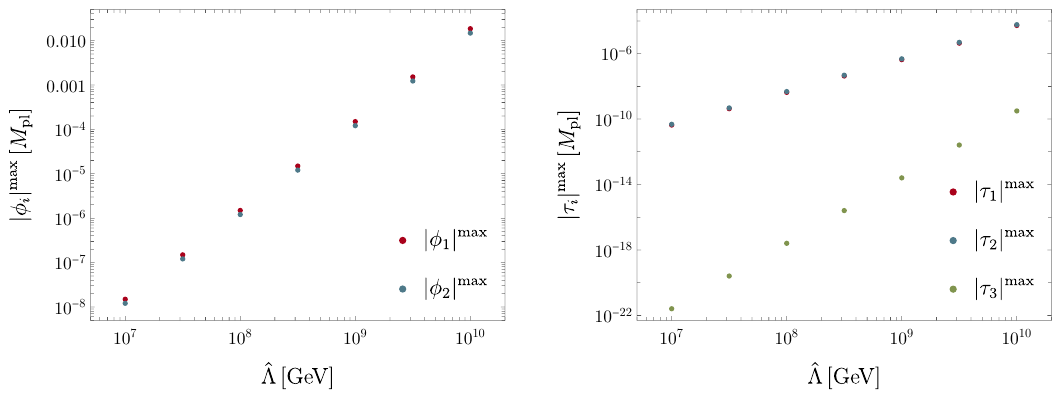
Figure 5 . The maximum values of φ i ( i = 1 , 2) (left) and τ i ( i = 1 – 3) (right) during inflation as functions of Λ . Red, blue, and green points correspond to i = 1 , 2 , and 3 ,